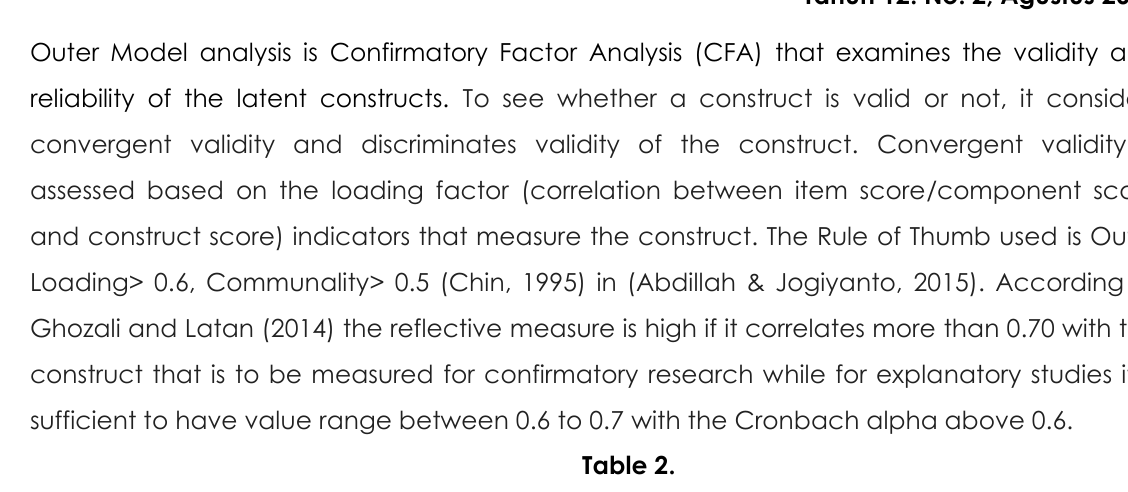
Validity Test Result of the Instrument Using Loading Factor Item Loading